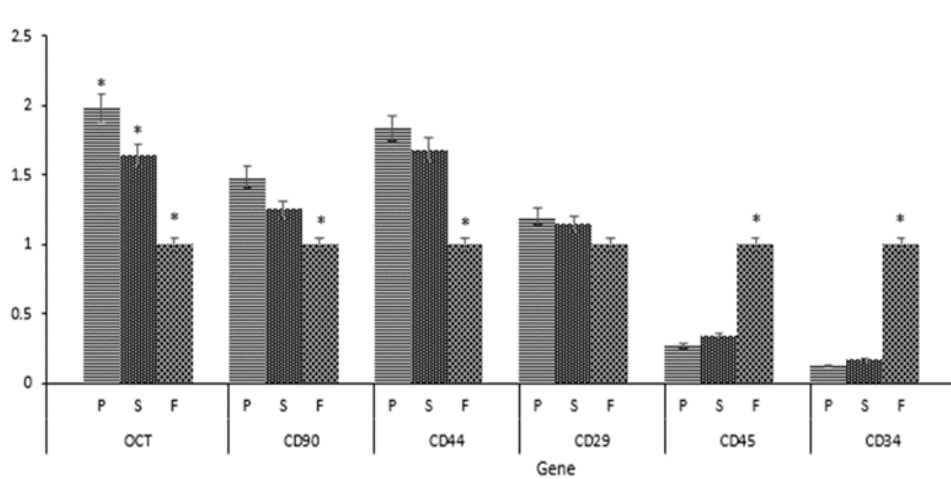
Figure 7. Semi-quantitative data from the gels using ImageJ software. P: peri-ovarian region; S: subcutaneous abdominal; F: falciform ligament; * p < 0.05.